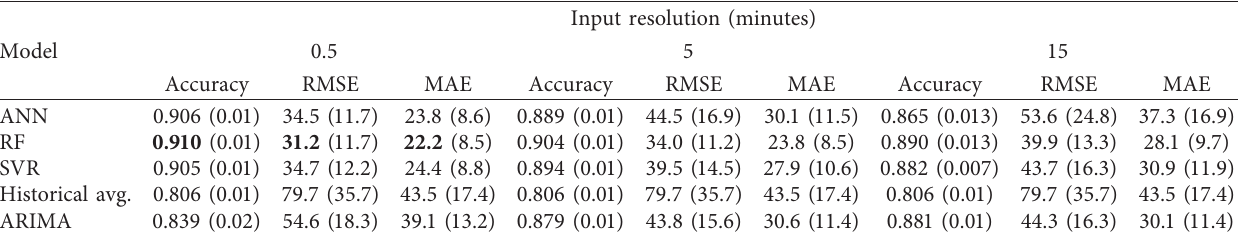
Table 1: Traffic volume prediction under all conditions.